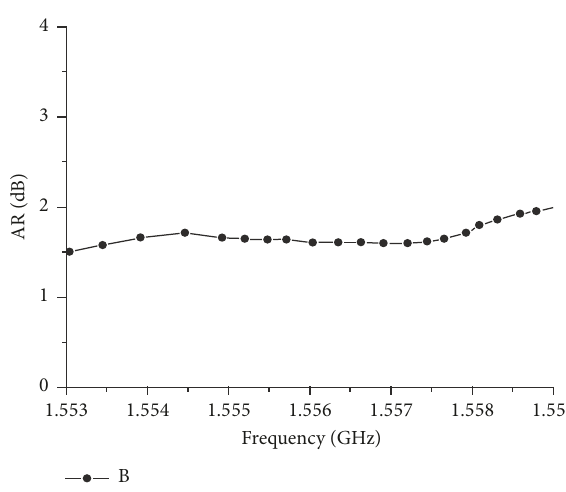
Figure 4: Axial ratio of simulation antenna unit.